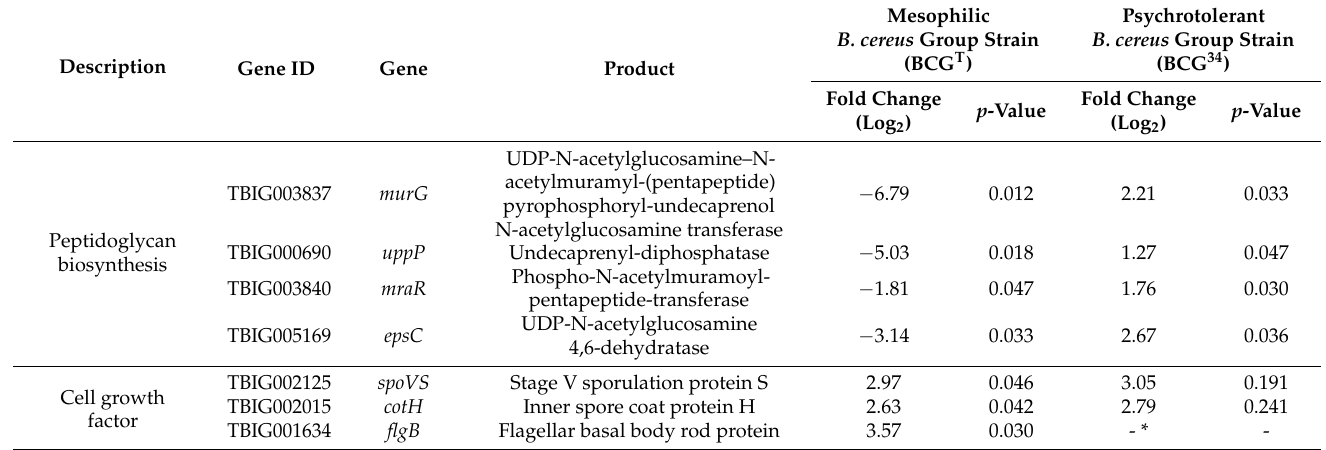
Table 7. Differential gene expression related to the cell membrane and cell wall of the mesophilic B. cereus group strain (BCG T ) and the psychrotolerant B. cereus group strain (BCG 34 ) grown at 10 ◦ C compared to growth at 30 ◦ C.